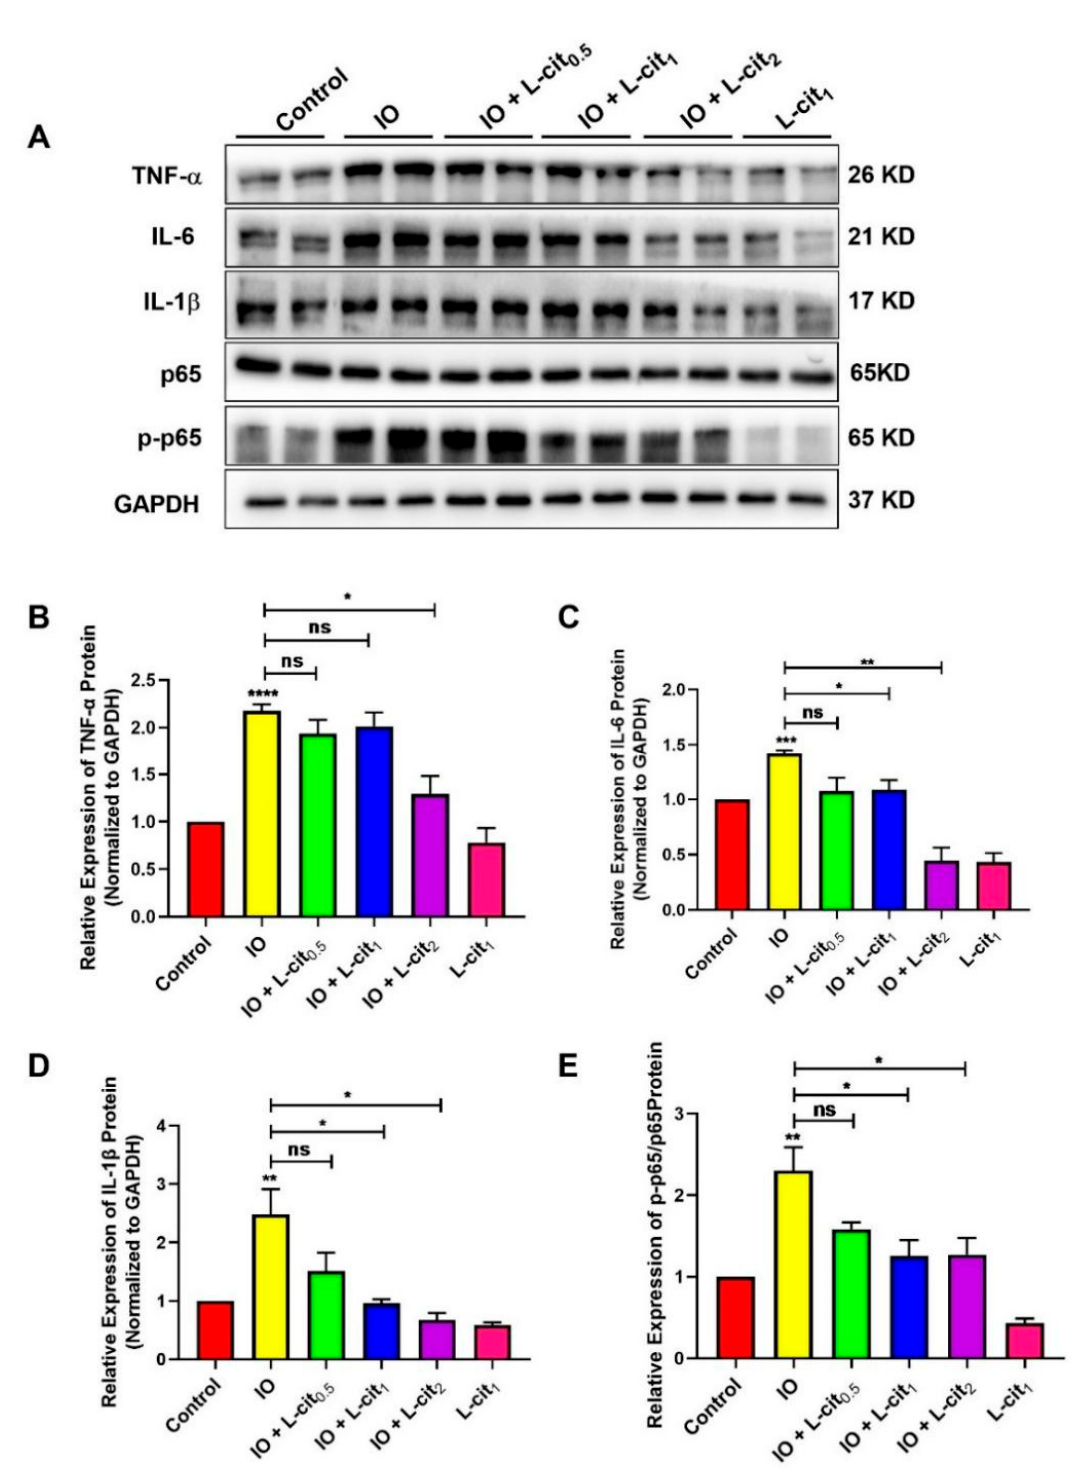
Figure 4. L-cit suppresses NF- κ B signaling pathway induced by iron overload in mouse thymus. Mice were intraperitoneally injected with iron dextran 50 mg/kg, and L-cit were given by gav- age administration the dosage of 0.5, 1.0, and 2.0g/kg/day. Immunoblot analyses were